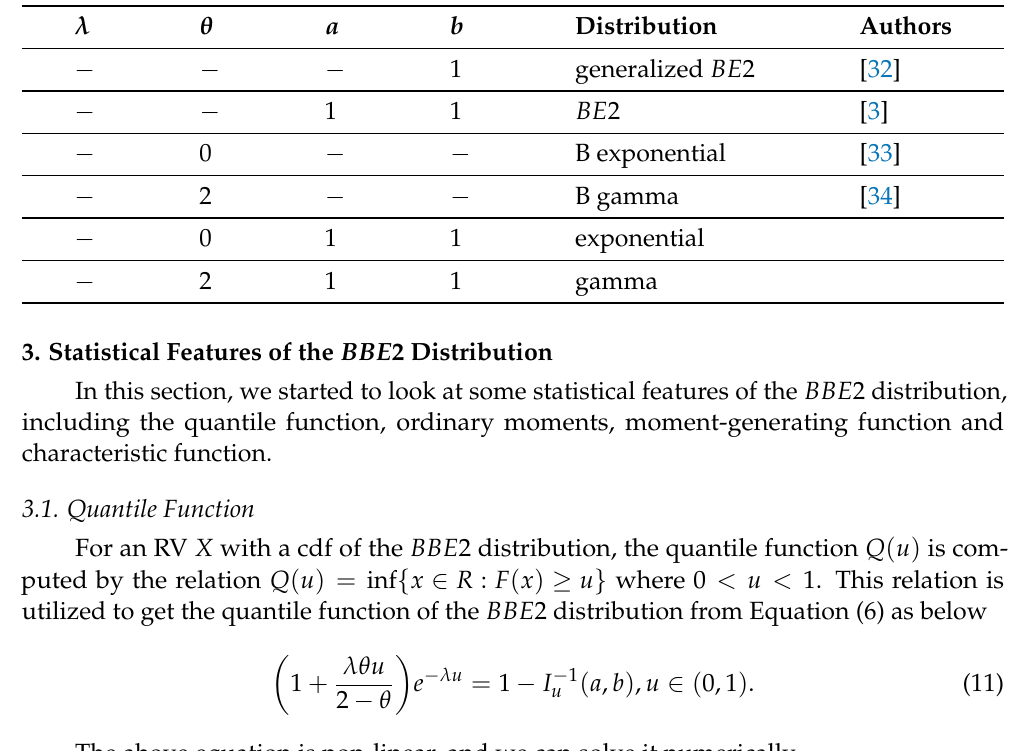
Table 1. Some sub-models of the BBE 2